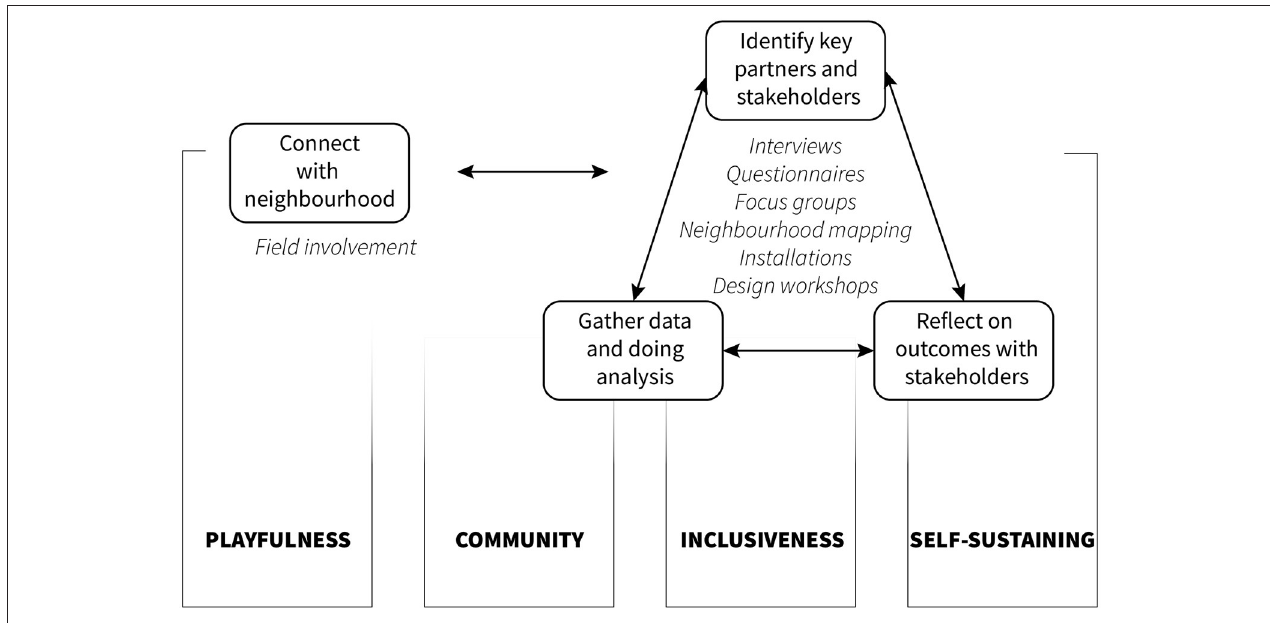
FIGURE 6 | The design framework suggests a sequence of activities and which methods to be used in